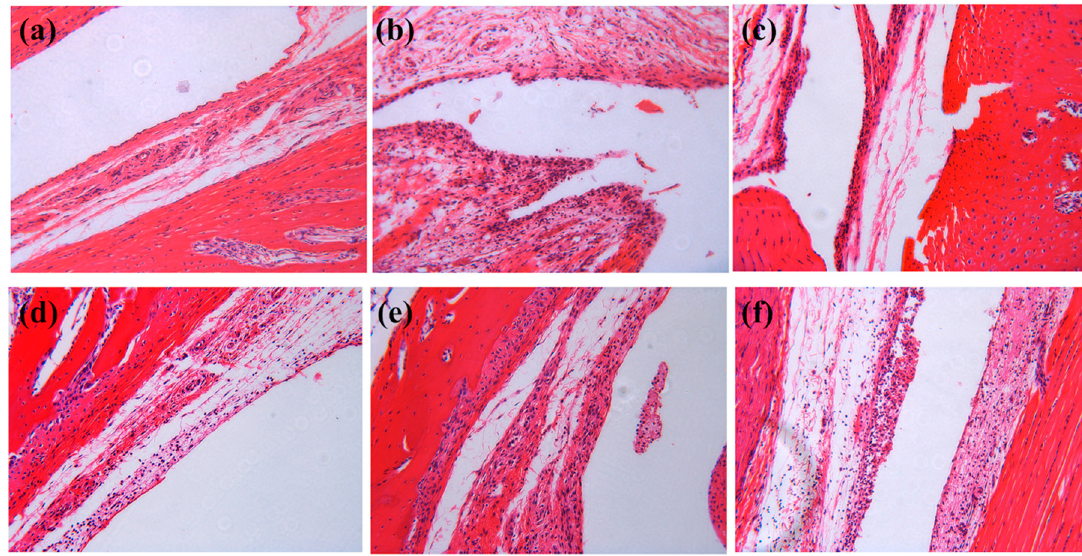
Figure 7. Histological examination of H and E stained ankle joint tissues of normal group (a), model group (b) , Col, H, M, and L treated group (c – f) .